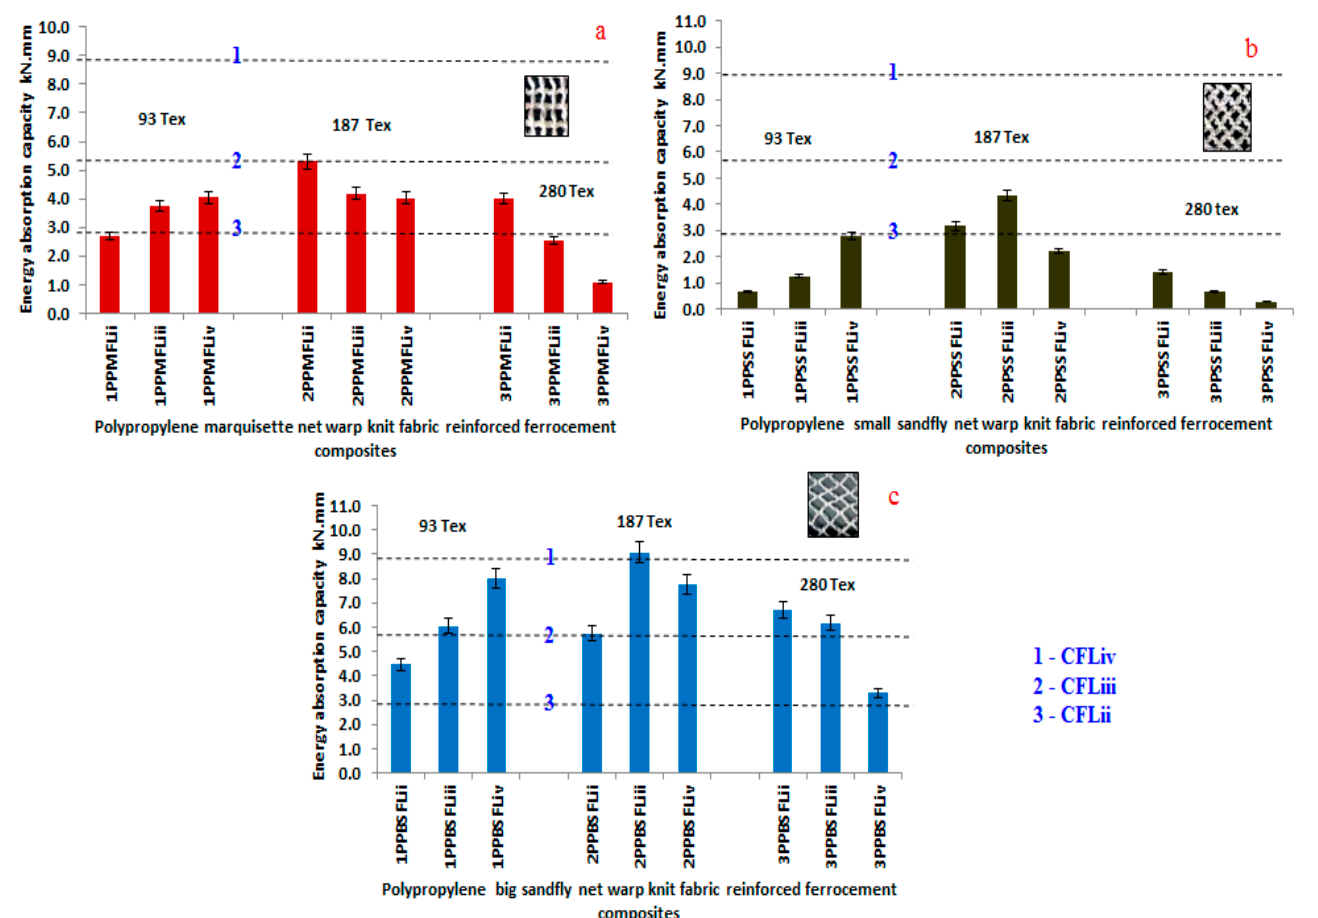
Figure 10. Energy absorption capacity of ( a ) marquisette, ( b ) small sandfly, and ( c ) big sandfly net polypropylene warp knitted reinforced ferrocement composites.